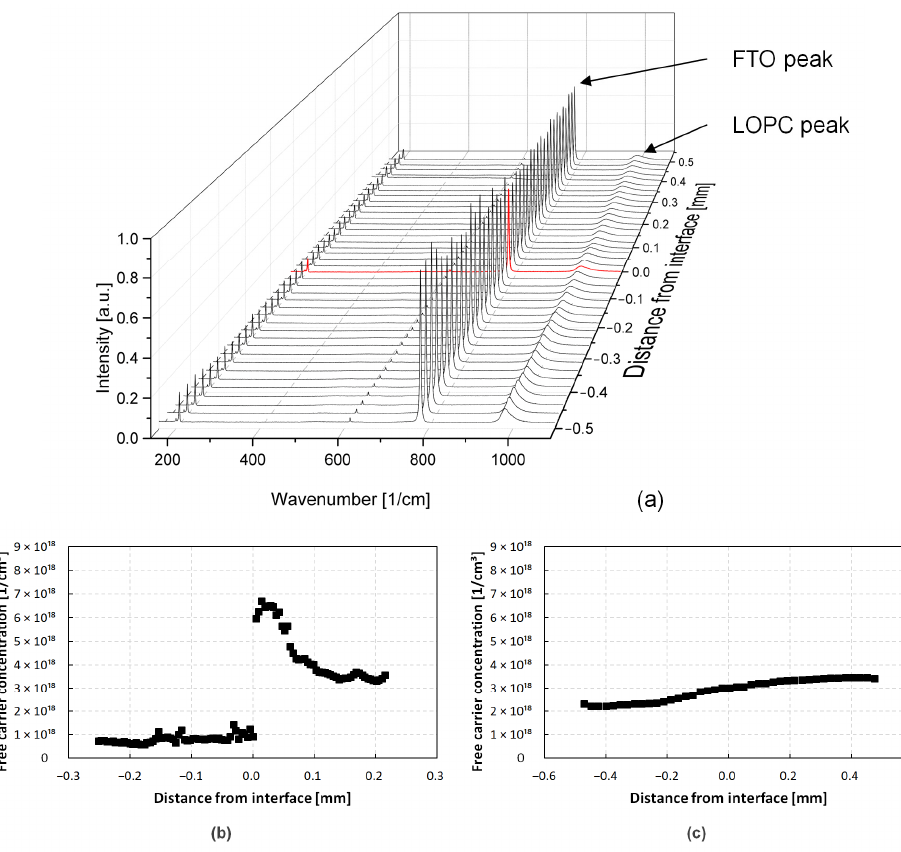
Figure 5. ( a ) Line scan of Raman spectra taken from crystal B; the position of the seed–crystal interface is marked in red; ( b , c ) measured free carrier concentrations across the seed–crystal interface of ( b ) crystal A and ( c ) crystal B, evaluated from the LOPC peak position. A positive distance from interface marks the area of grown crystal, while a negative distance indicates an area of the seed of the crystal.